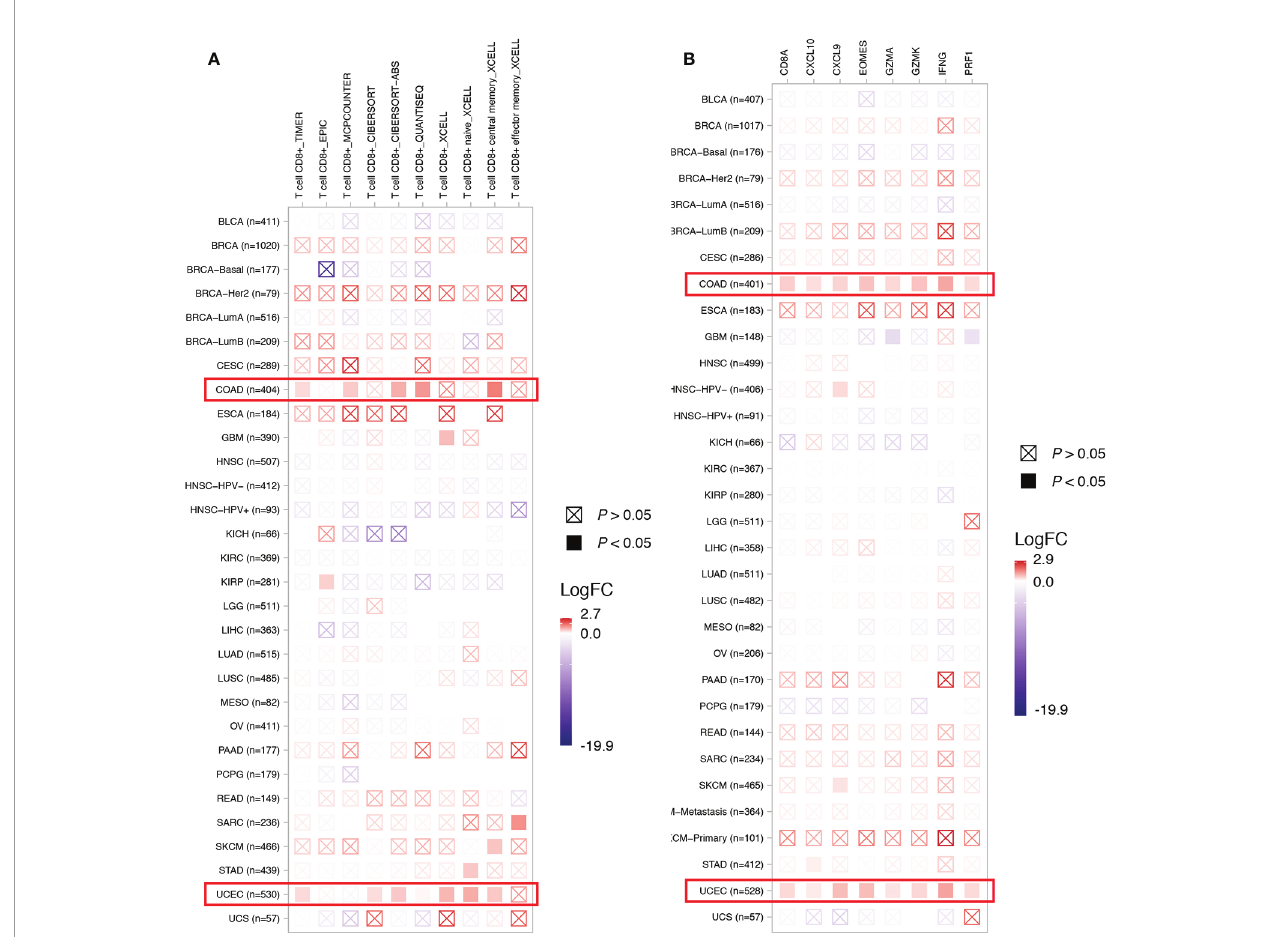
FIGURE 5 | Association between KDM5C alterations and CD8+ T cell abundance (A) and T effector signature (B) . BLCA, Bladder Urothelial Carcinoma; BRCA, Breast invasive carcinoma; CESC, Cervical squamous-cell carcinoma and endocervical adenocarcinoma; COAD, Colon adenocarcinoma; ESCA, esophageal carcinoma; GBM, Glioblastoma multiforme; HNSC, head and neck squamous cell carcinoma; KICH, kidney chromophobe; KIRC, kidney renal clear cell carcinoma; KIRP, kidney renal papillary cell carcinoma; LIHC, Liver hepatocellular carcinoma; LUAD, lung adenocarcinoma; LUSC, lung squamous- cell carcinoma; MESO, mesothelioma; OV, ovarian serous cystadenocarcinoma; PAAD, pancreatic adenocarcinoma; PCPG, pheochromocytoma and paraganglioma; READ, rectum adenocarcinoma; SKCM, Skin cutaneous melanoma; STAD, Stomach adenocarcinoma; UCEC, Uterine corpus endometrial carcinoma; UCS, uterine